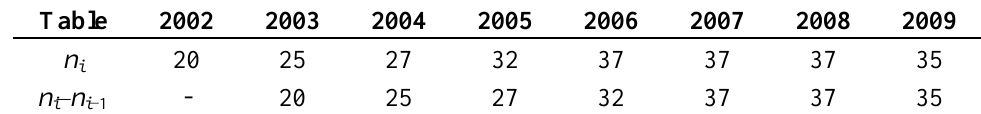
) and number of valid i – n i i −1